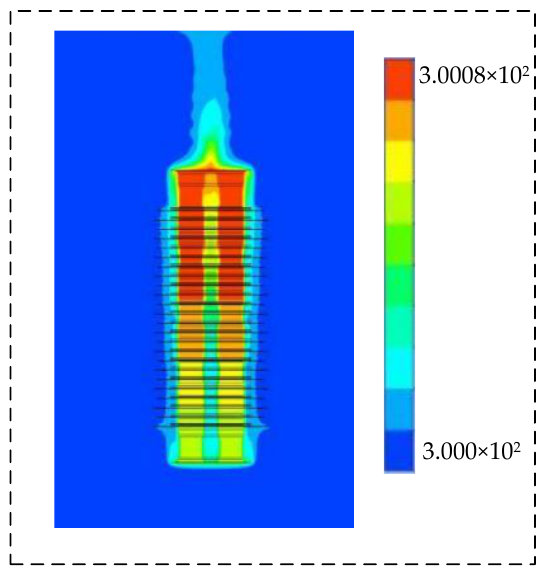
Figure 4. Steady-state temperature distribution of the arrester under monopole metal loop operation mode.